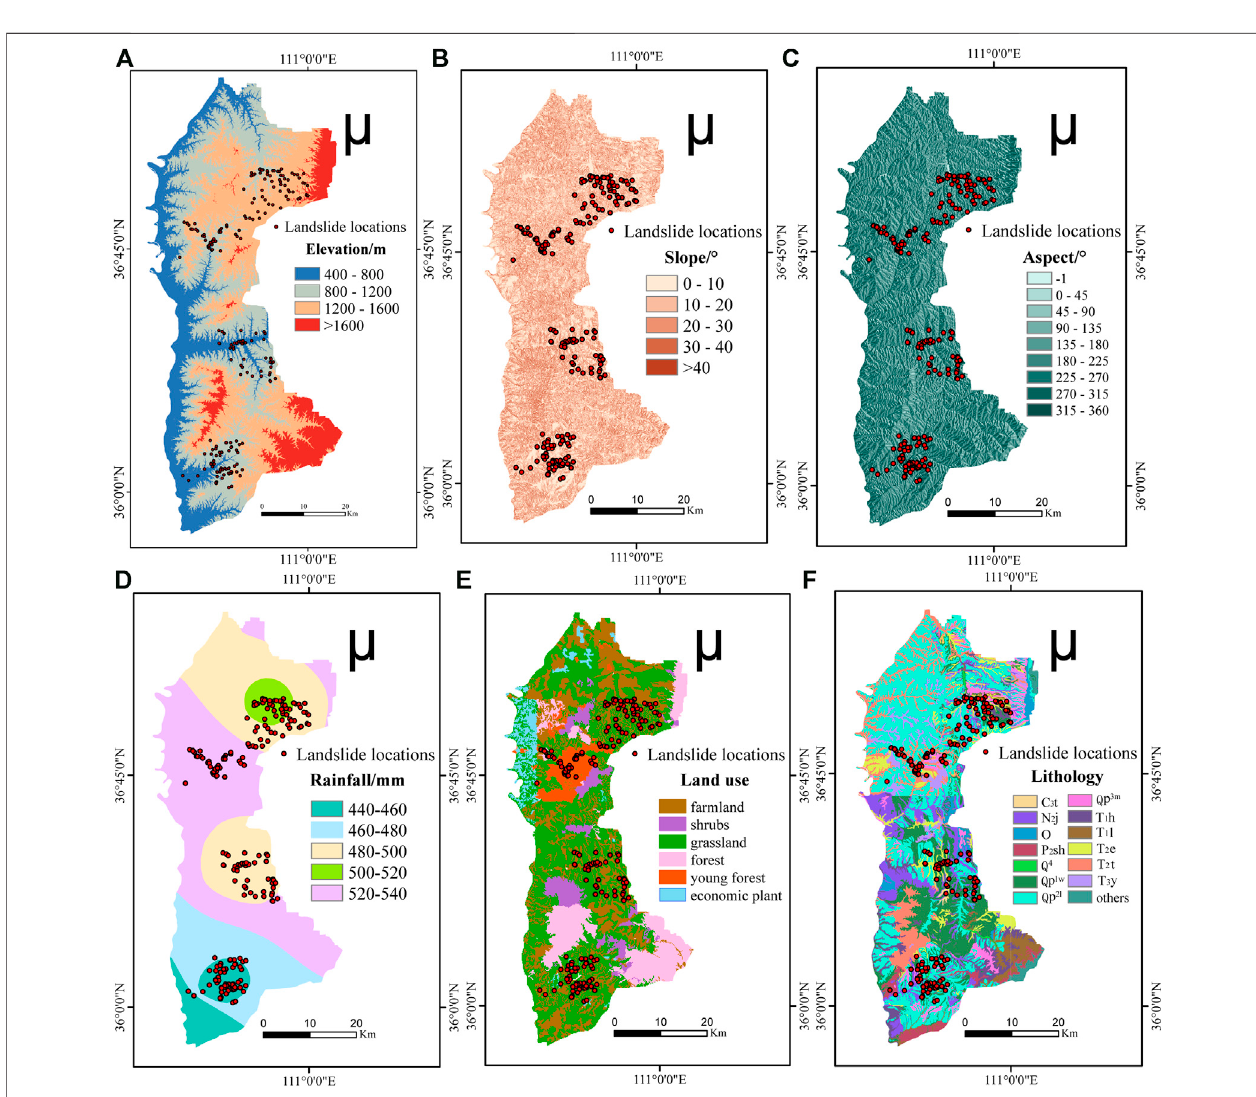
FIGURE 3 | Causal factors used in landslide susceptibility modelling. The red dots represent landslide points in the study area: (A) elevation, (B) slope, (C) aspect, (D) rainfall, (E) land use, (F) lithology, (G) soil erosion intensity, (H) plan curvature, (I) pro fi le curvature, and (J) vegetation coverage.